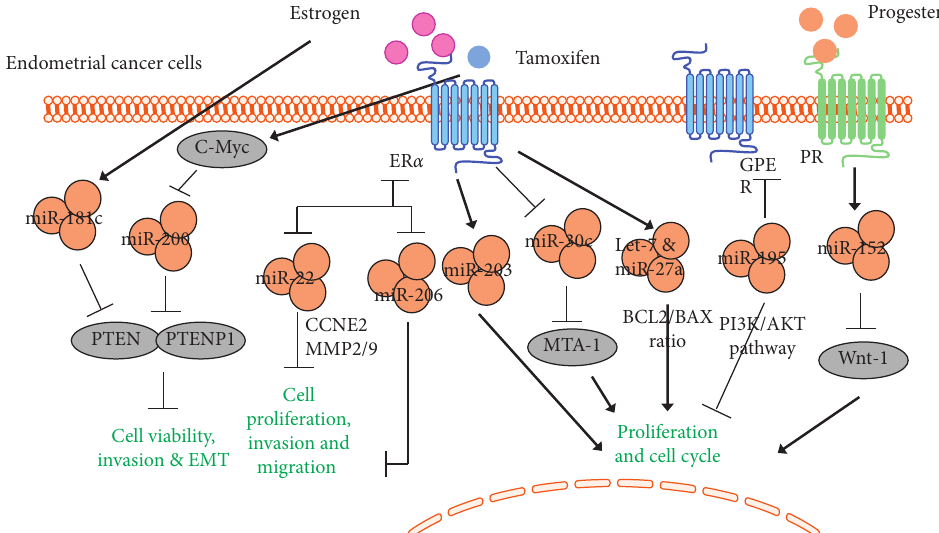
Figure 3: The interaction of miRNAs and estrogen in endometrial cancer. Several miRNAs have been reported to interact with estrogen and its receptor in endometrial cancer, including miR-181c, miR-200, miR-22, miR-206, miR-203, miR-30c, Let-7, miR-27a, miR-195, and miR- 152. Solid arrow: induction; flat-ended arrow: inhibition.